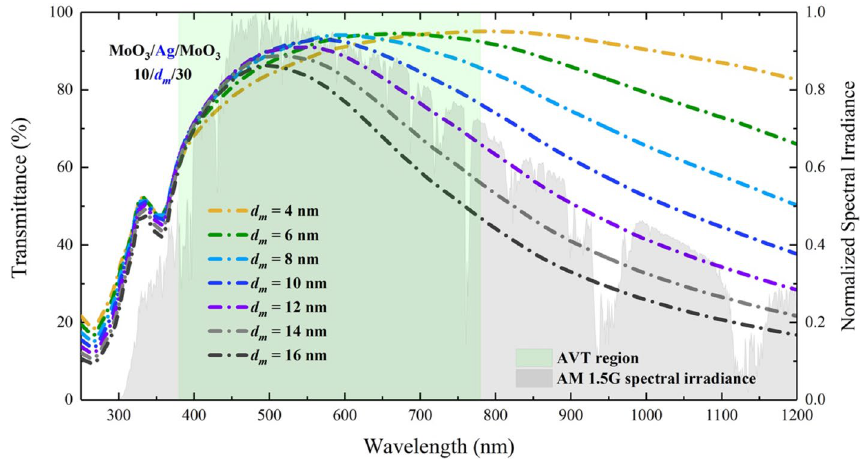
Figure 1. Calculated transmittance spectra of MoO 3 /Ag/MoO 3 ( 10 nm / d m / 30 nm ) DMD transparent top contact. The green shaded area shows the region where AVT is calculated.